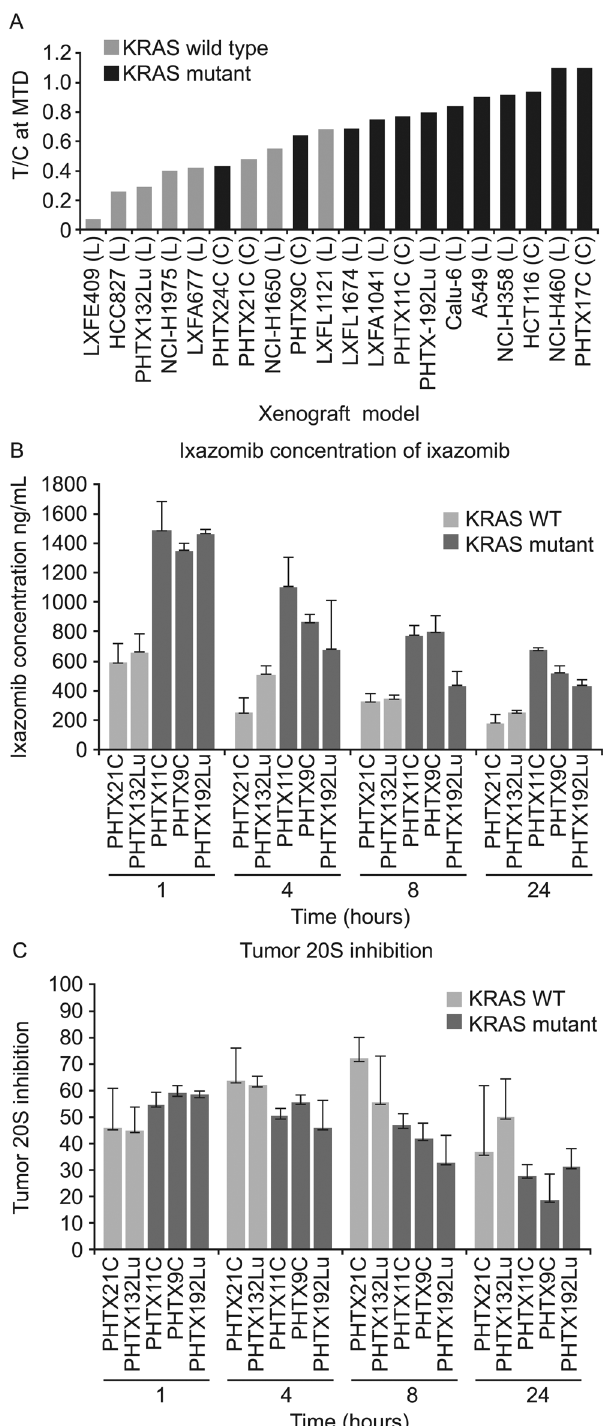
Fig 1. Ixazomib activity in tumor xenografts. (A) Antitumor activity of ixazomib in 14 non small cell lung (NSCLC) and 6 colon xenograft models. The panel included both cell line-derived and primary human xenografts harboring either WT or mutant KRAS. Tumor-bearing animals (n = 8 – 10 per group) were treated with either vehicle or MTD dose of ixazomib (between 11 and 14 mg/kg, IV, BIW) for approximately three weeks. T/C was calculated by dividing average tumor volume of drug treated animals by that of vehicle treated animals on day 19 – 21. Tumor concentration of ixazomib (B) and 20S proteasome inhibition ( β 5